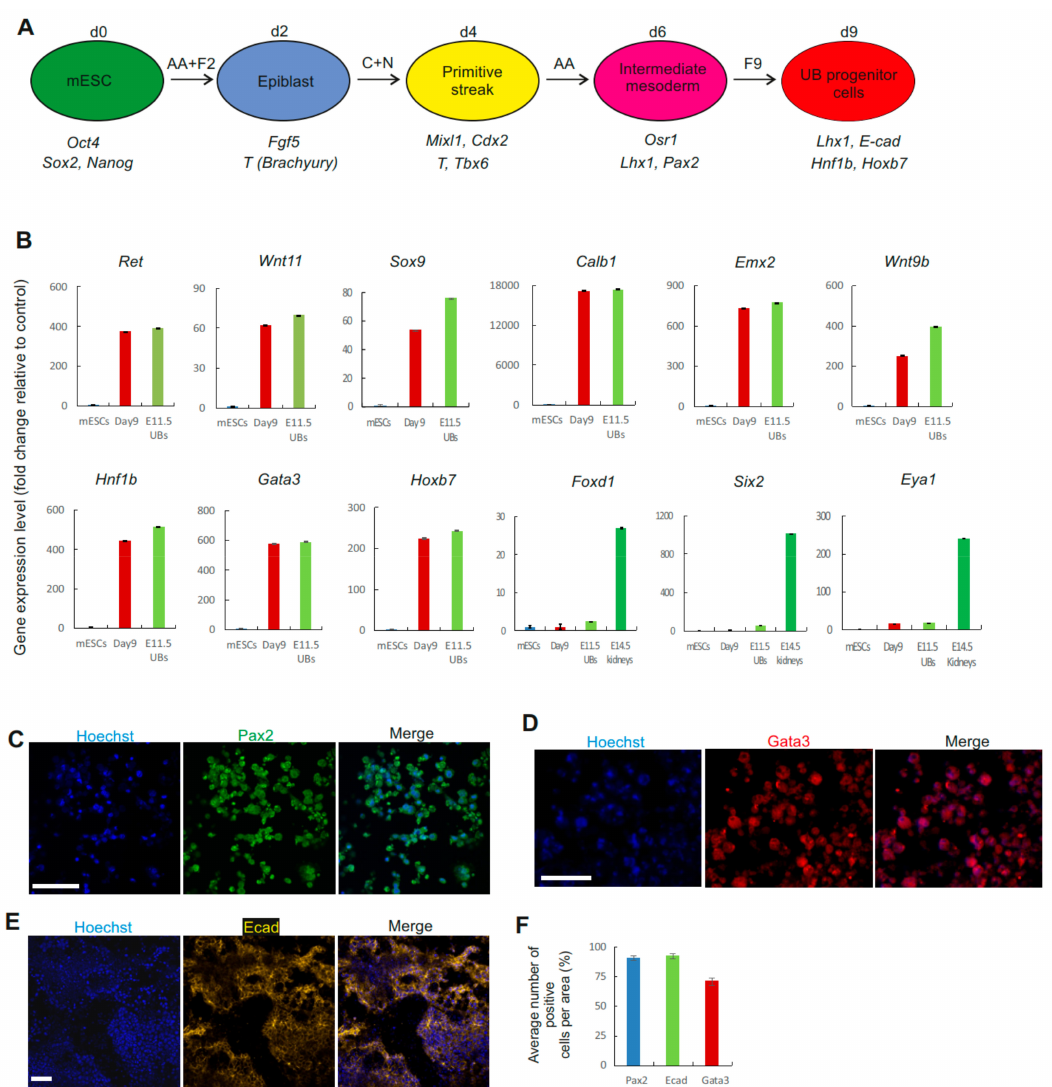
Figure 1. Di ff erentiation of mouse embryonic stem cells (mESCs) to ureteric bud (UB) progenitor cells. ( A ) Schematic of the di ff erentiation protocol of mESCs into UB progenitor cells. AA: Activin A; F2: FGF2; C: CHIR99021; N: Noggin; F9: FGF9. ( B ) Graphs of qPCR results showing the gene expression (fold change) of ureteric bud markers relative to mESC. No expression of stroma (Foxd1) and nephron progenitor cell markers (Six2 and Eya1) was observed at day 9 of di ff erentiation. ( n = 3). ( C – E ) Immunocytochemistry of Pax2, Ecad, and Gata3 in mESCs on day 9 of di ff erentiation. Scale bars, 50 µ m. ( F ) Quantification of the number of cells expressing Pax2, Ecad, and Gata3 at day 9 of di ff erentiation. n = 3 samples per marker (3 randomly chosen areas in 3 independent